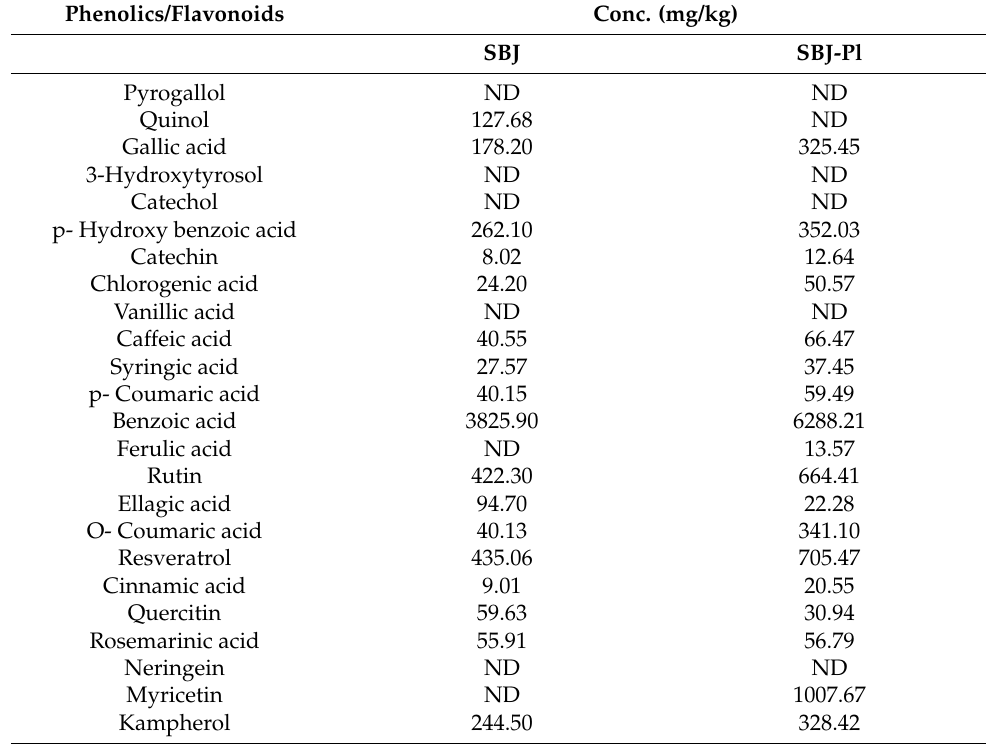
Table 4. HPLC analysis of the phenolic, flavonoid and organic acid content of sea buckthorn